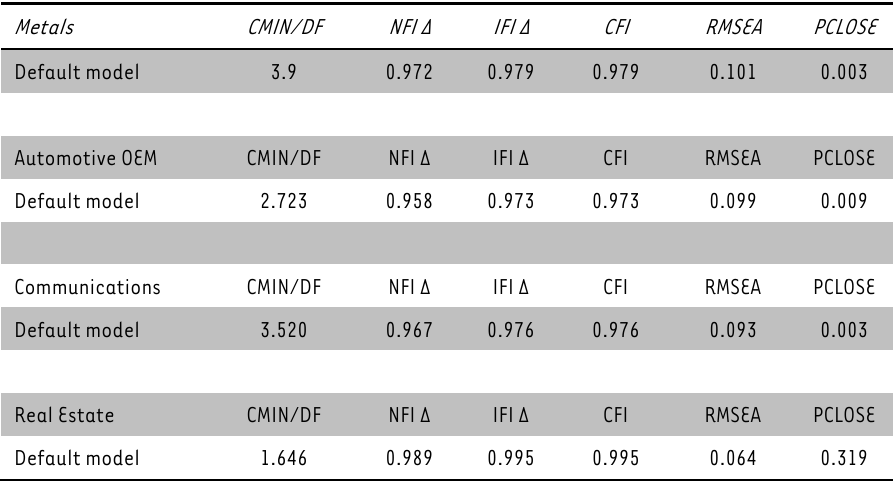
TABLE 3: Summary of SEM estimations for the different